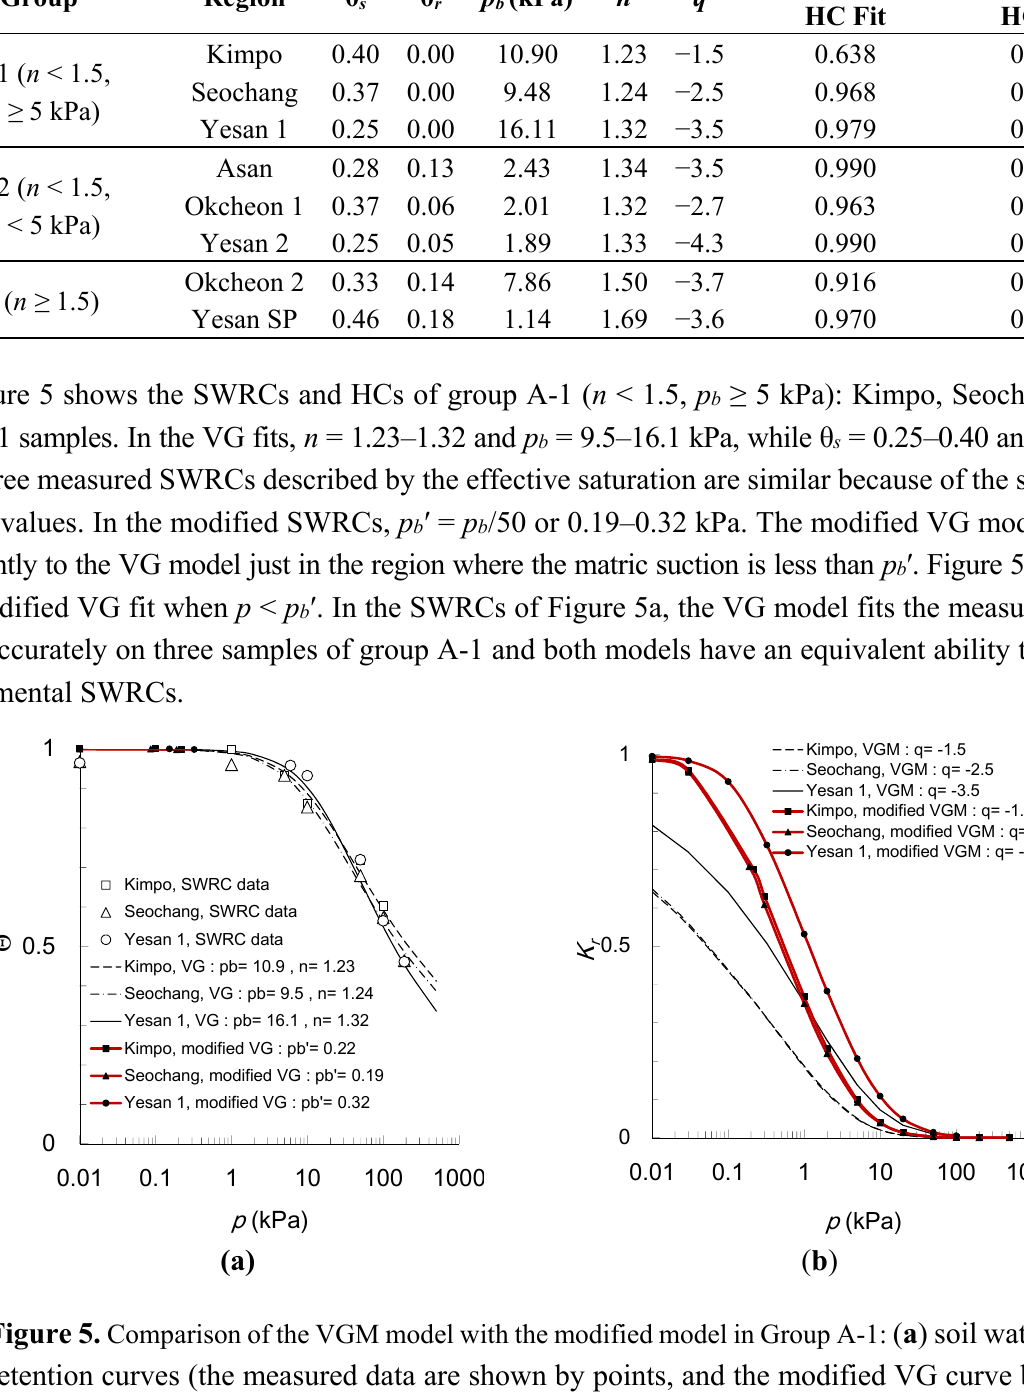
Table 2. Parameters of the van Genuchten-Mualem model for each SWRC and HC. Group